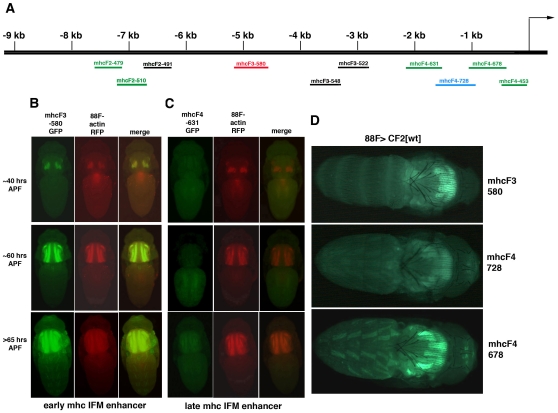
CF2 overexpression does not directly inhibit mhc transcription in the IFM.A) Map of the upstream region of mhc, showing regions that drive muscle expression. Green bars (late IFM elements) denote elements that express later in IFM development (after ∼70 hrs APF, class 3), red indicates an element (early IFM element) that is expressed at the onset of myofibrilogenesis (∼40 hrs AFP at 22°C, class I), and blue an early IFM element that ceases expression in early adulthood (class 2). The black bars denote enhancer elements that drive expression in muscle types other than IFM. B) Expression patterns of GFP and RFP in animals carrying both the mhcF3-580-GFP early enhancer and an 88F-RFP reporter. C) Expression patterns of GFP and RFP in animals carrying both the mhcF4-631-GFP late enhancer and an 88F-RFP reporter. D) Expression of the three different classes of mhc reporters in a CF2 gain of function background.